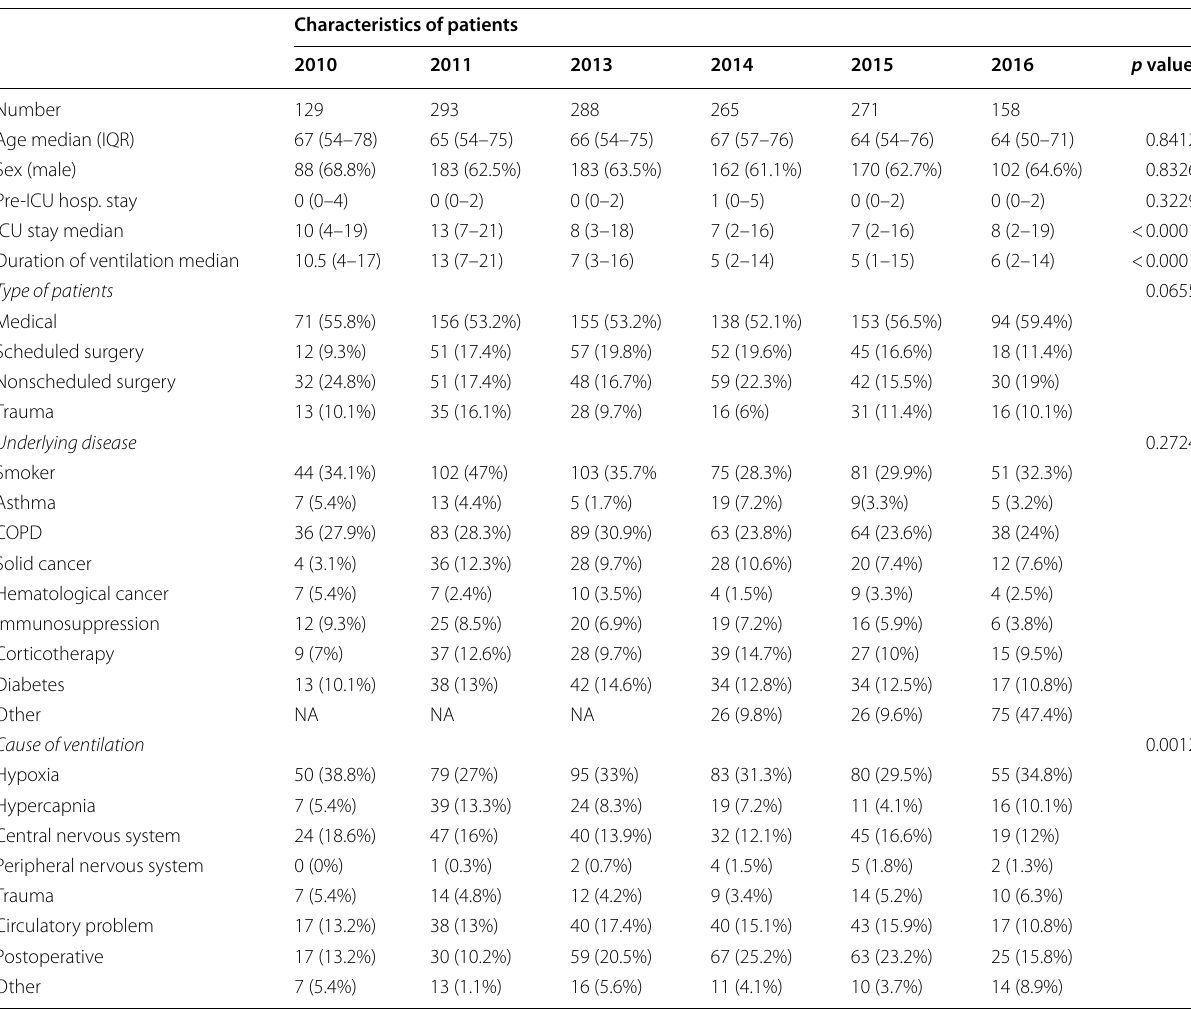
Table 1 Characteristics of ventilated